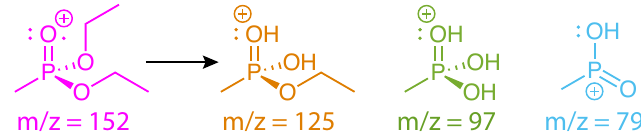
Figure 4. ( a ) Transient signals of ions from DEMP: DEMP · + ( m / z = 152, magenta), PO 3 H 3 H 10+ ( m / z = 125, orange), PO 3 CH 6+ ( m / z = 97, green), and PO 2 CH 4+ ( m / z = 79, blue). The dark solid lines denote fits to Equation (1). ( b ) Residual ion signals after exponential dynamics are subtracted. ( c ) FFT of residual DEMP · + signal in ( b